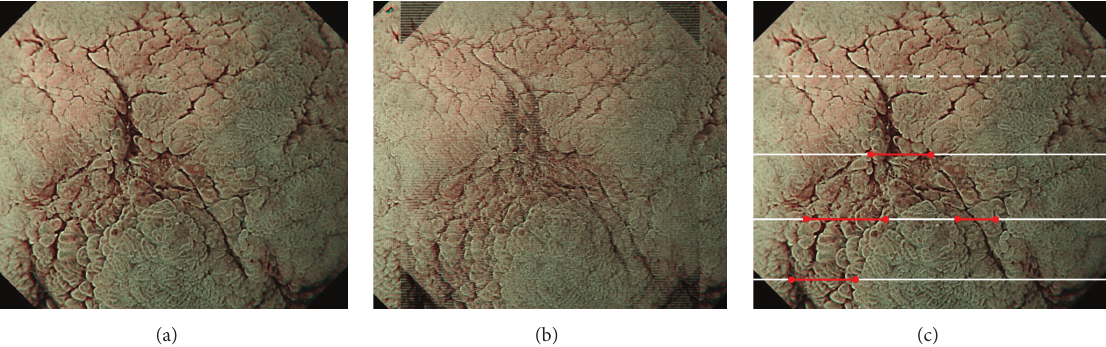
Figure 3: (a) A 2D sample of the resection specimen. (b) Example of parallax images (a 3D monitor and 3D glasses are required for three- dimensional visualization). (c) Adenocarcinoma components are detected in red line.